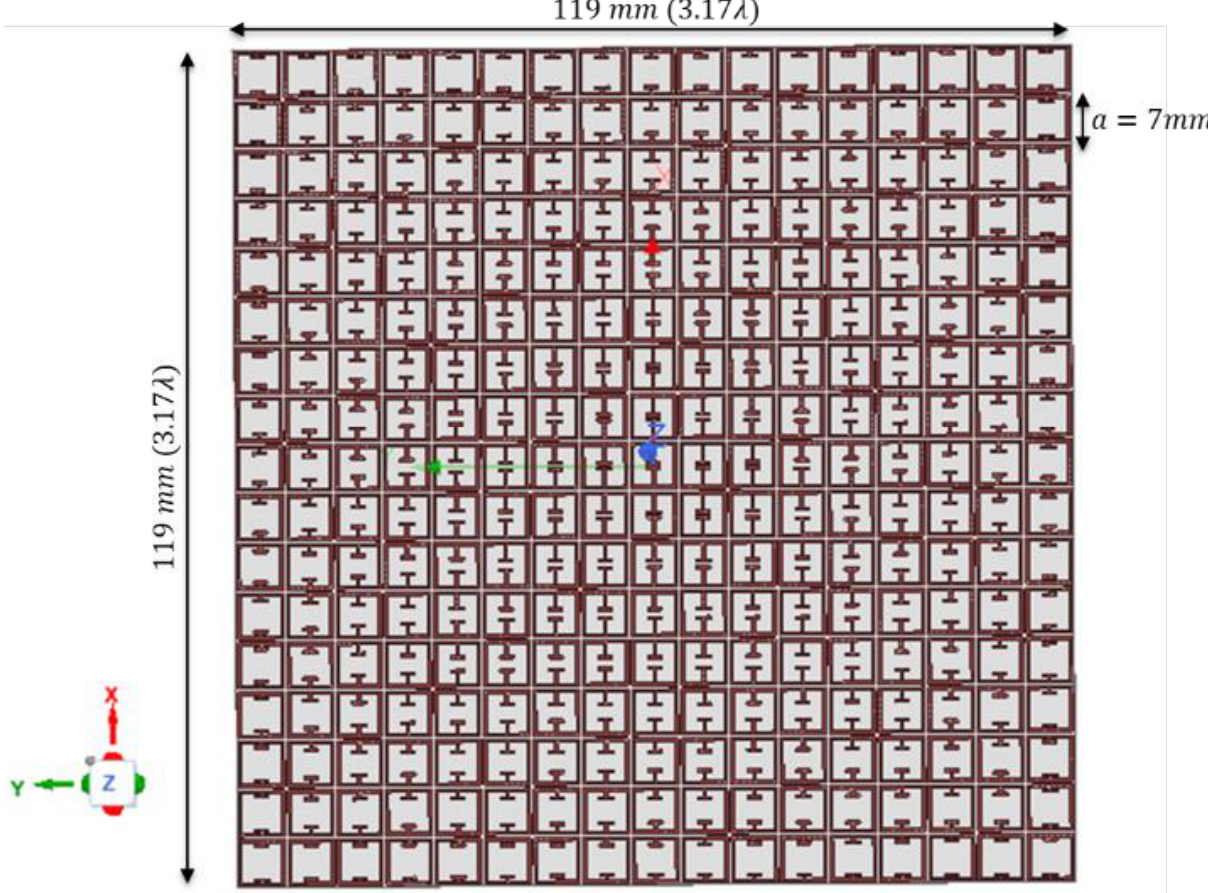
Figure 7. Proposed 2D GRIN Metasurface Lens for microwave imaging. The HFSS model setup to validate focusing action is shown in Figure 8a. Two ob- servation planes (both horizontal and vertical) were considered in this case. The solution frequency is 8 GHz, which is same as the 1D GRIN lens. The electric field distribution in the horizontal plane are shown in Figure 8b,c. A similar focusing action is observed with the 2D GRIN lens, while the free space results show the incident plane waves without any